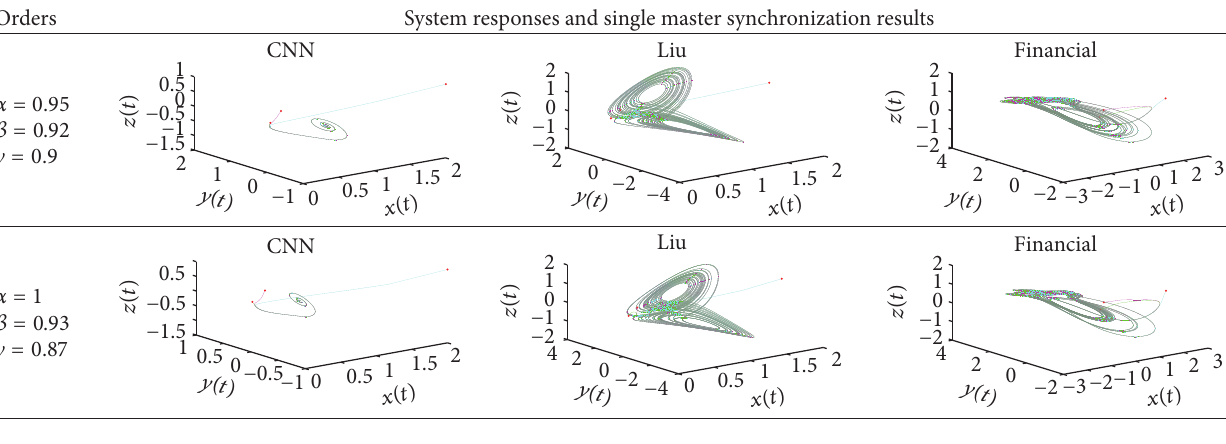
Table 5: Successful synchronization at different values of the fractional